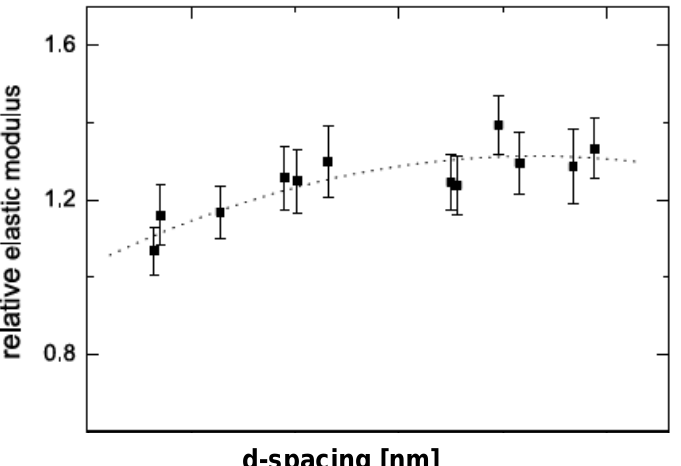
Figure 30. Increase in the elastic modulus of the composites as a function of the basal plane spacing of the filler. Reproduced from reference [135] with permission of